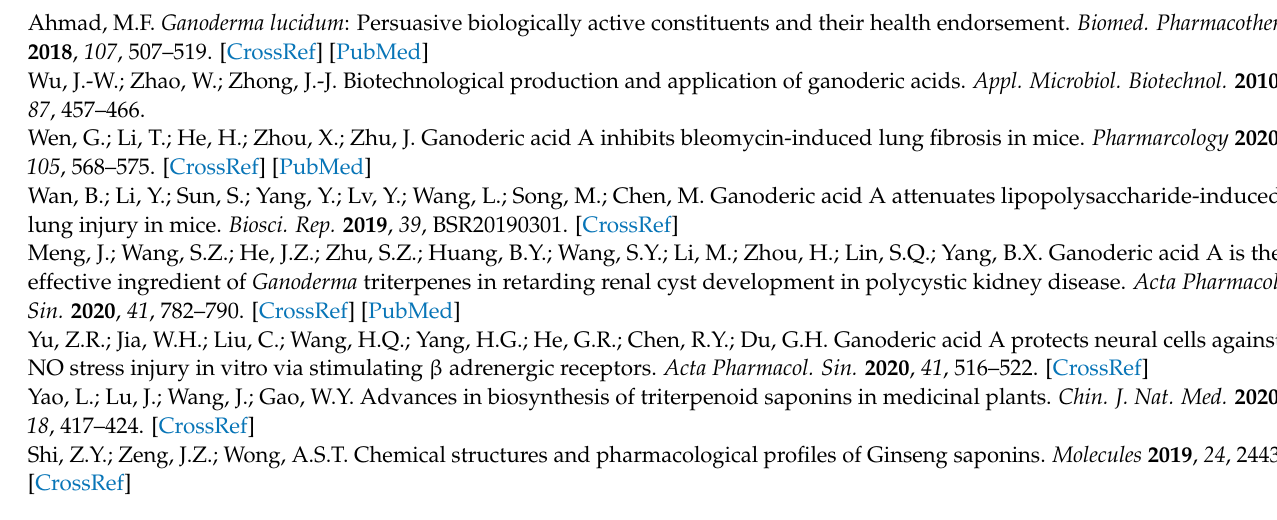
Figure S1: Mass analysis of GAA-G2 at the negative mode. Figure S2: Mass–mass analysis of the m/z 839.5 peak of GAA-G2 at the negative mode. Figure S3: Mass analysis of GAA-G3 at the negative mode. Figure S4: Mass–mass analysis of the m/z 1001.5 peak of GAA-G3 at the negative mode. Figure S5: Mass analysis of GAA-G4 at the negative mode. Figure S6: Mass–mass analysis of the m/z 1163.6 peak of GAA-G4 at the negative mode. Figure S7: The 1 H-NMR (700 MHz) spectrum of GAA-G2 in pyridine-d5. Figure S8: The 13 C-NMR (176 MHz) spectrum of GAA-G2 in pyridine-d5. Figure S9: The Dept-135 spectrum of GAA-G2 in pyridine-d5. Figure S10: The HSQC (600 MHz) spectrum of GAA-G2 in pyridine-d5. Figure S11: The HMBC (700 MHz) spectrum of GAA-G2 in pyridine-d5. Figure S12: The 1 H- 1 H COSY (700 MHz) spectrum of GAA-G2 in pyridine-d5. Figure S13: The NOESY (700 MHz) spectrum of GAA-G2 in